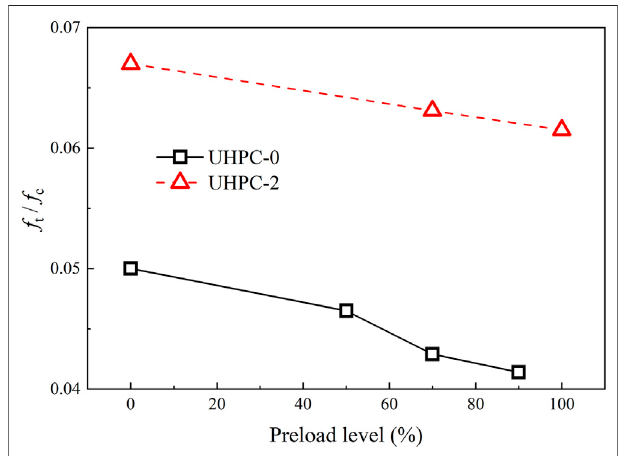
FIGURE 7 | Splitting tensile strength of UHPC-0 with increasing rehydration